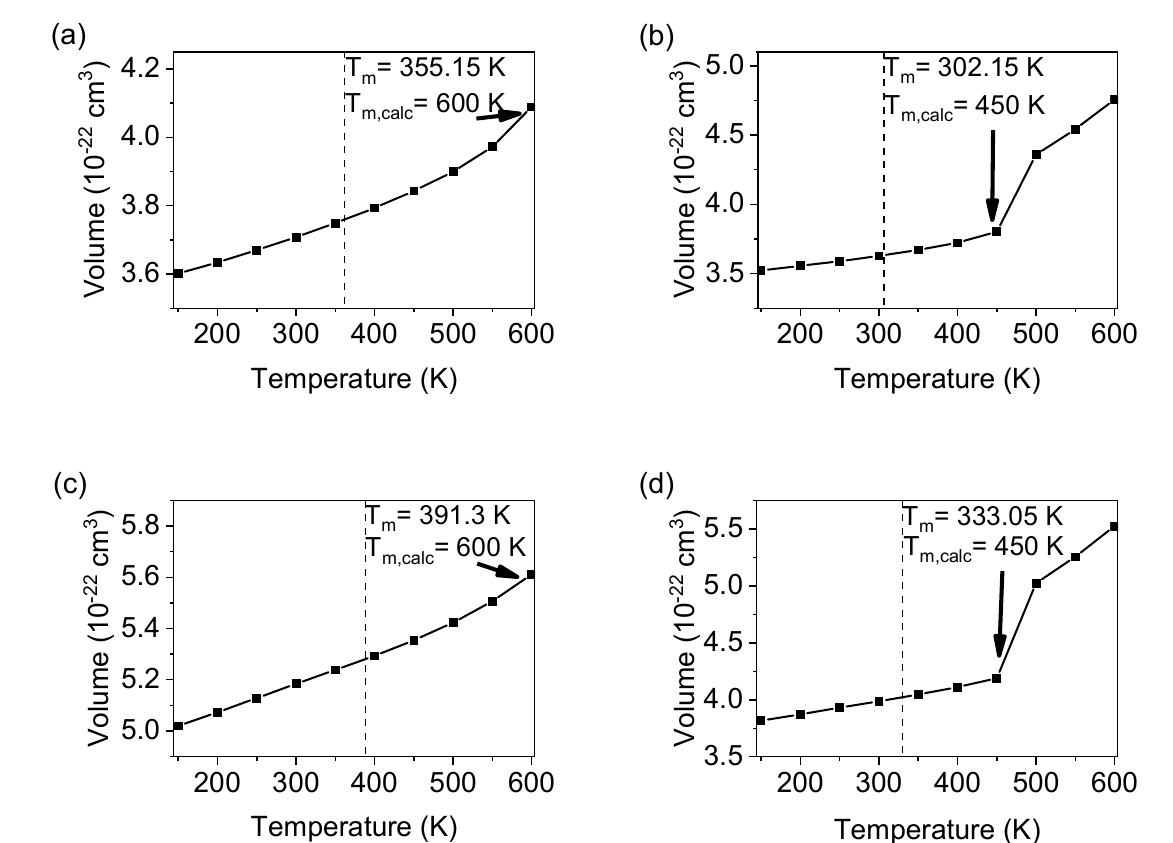
Figure 3. The volume as a function of temperature for monomers: ( a ) BADCy, ( b ) LECy, ( c ) SiCy-3, and ( d ) SiMCy with 0% voids. The calculated melting temperature ( T m,calc ) is represented by the discontinuity or inflection (arrow). The results were compared to previously reported experimental melting temperatures (dotted line).